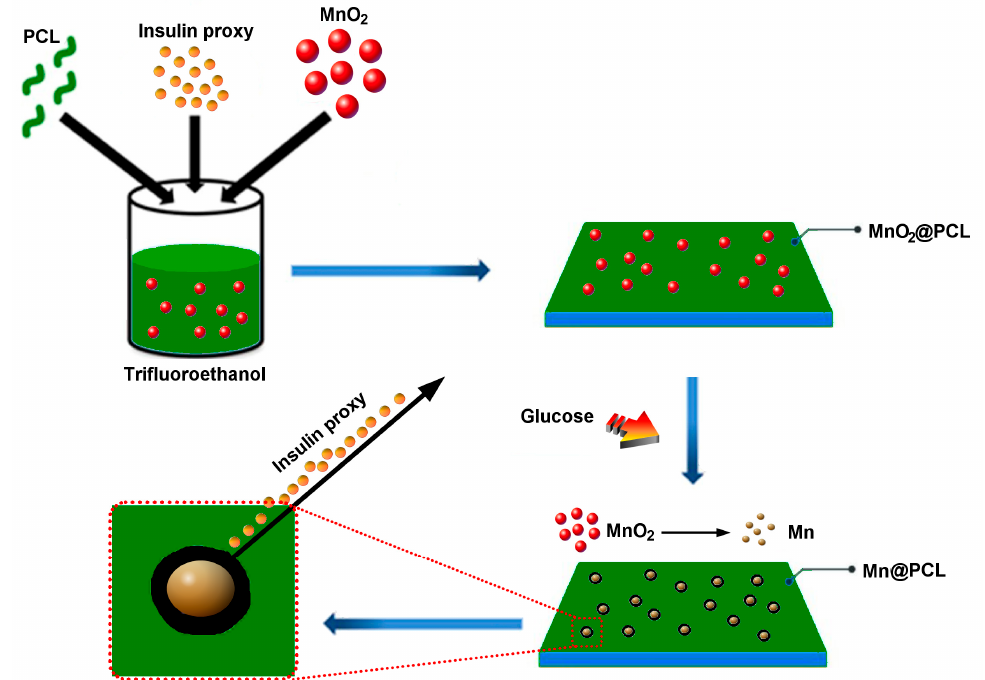
Figure 1 Figure 1. Schematic description of the concept behind the smart delivery of an insulin proxy from PCL thin films supplemented with MnO 2 as a redox-responsive metallic nanoparticle precursor. PCL, the insulin proxy and MnO 2 nanoparticles were mixed with 2,2,2-trifluoroethanol and cast inside a Petri dish. Once solidified, the film was exposed to glucose, which prompted the reduction of MnO 2 nanoparticles and their partial conversion to metallic Mn, leaving behind pores acting as channels for the release of the insulin